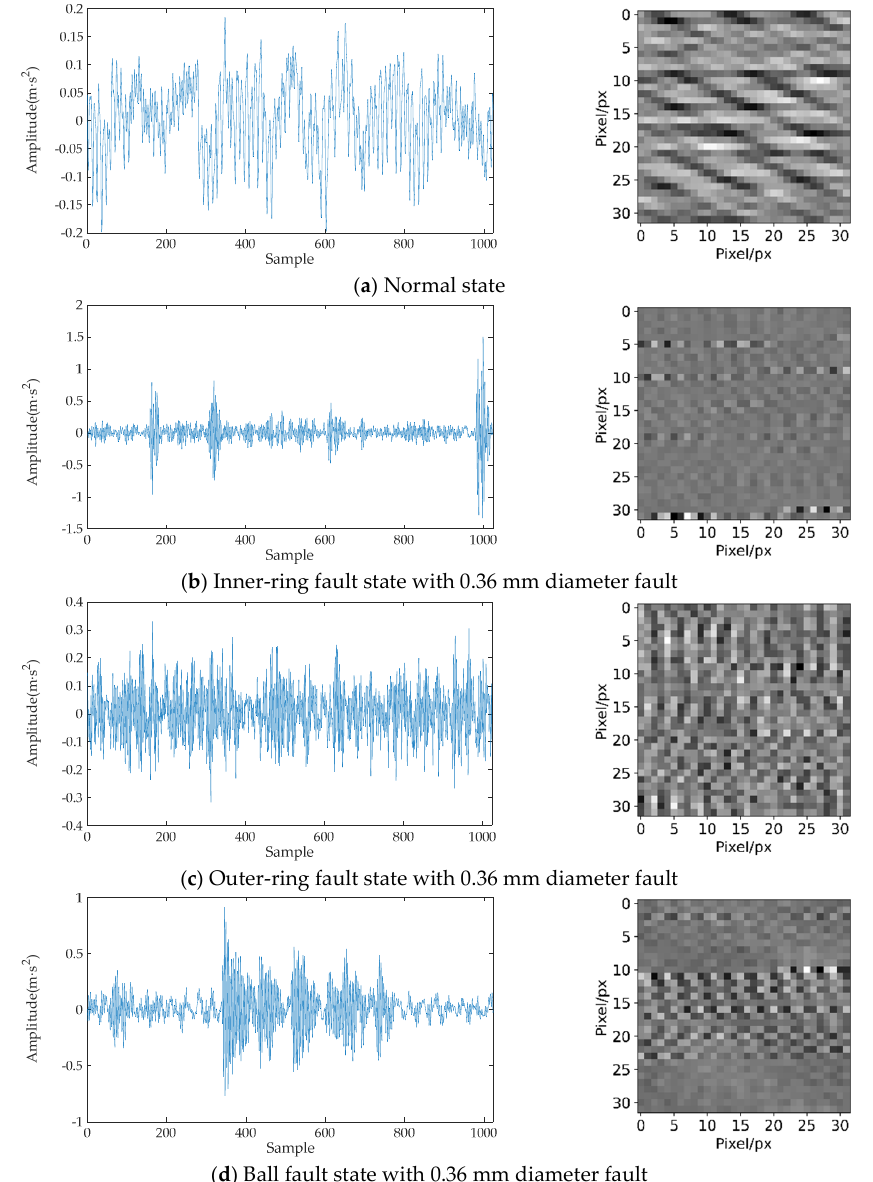
set of conversion results for the normal state and faulty states with the inner ring, outer ring, and ball fault in 0.36 mm diameter are shown from Figure 8a–d, respectively.